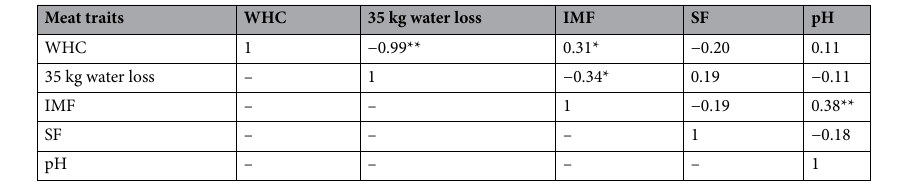
Table 2. Pearson correlation coefficients between WHC and other meat traits of all samples. WHC water holding capacity, IMF intramuscular fat, SF shear force. **p < 0.01, *p < 0.05.